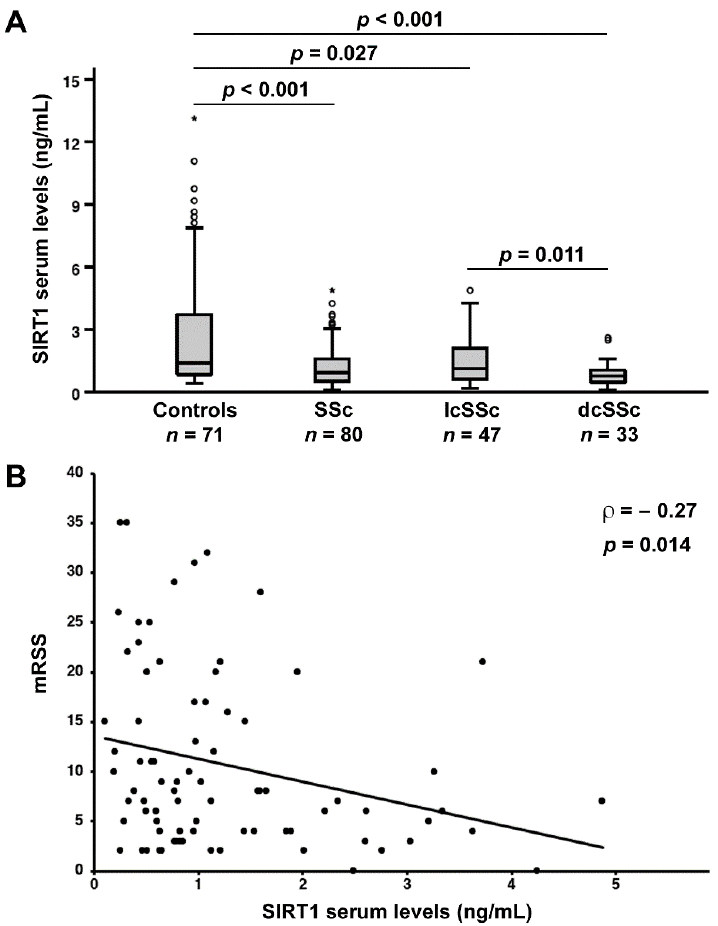
Figure 1. Serum levels of sirtuin 1 (SIRT1) are decreased, and correlate with the extent of skin fibrosis in systemic sclerosis (SSc) patients. ( A ) Serum SIRT1 levels in healthy controls, SSc patients and limited cutaneous SSc (lcSSc), and diffuse cutaneous SSc (dcSSc) subsets. Data are presented as box plots. Each box denotes the 25th to 75th percentiles. Lines outside the boxes are the 10th and 90th percentiles. Lines inside the boxes denote the median, circles denote the outliers, and asterisks denote the extreme values. ( B ) Correlation of SIRT1 levels with modified Rodnan skin thickness score (mRSS) in SSc patients. Data are displayed as scatterplot, where each dot represents a patient. Correlation coefficient ( ρ ) and p values are indicated.